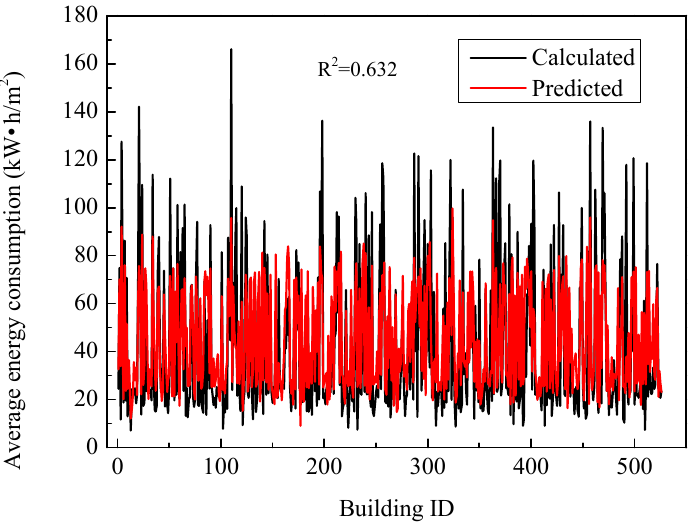
Figure 8. Comparisons of the multi-zone method and single-zone method.